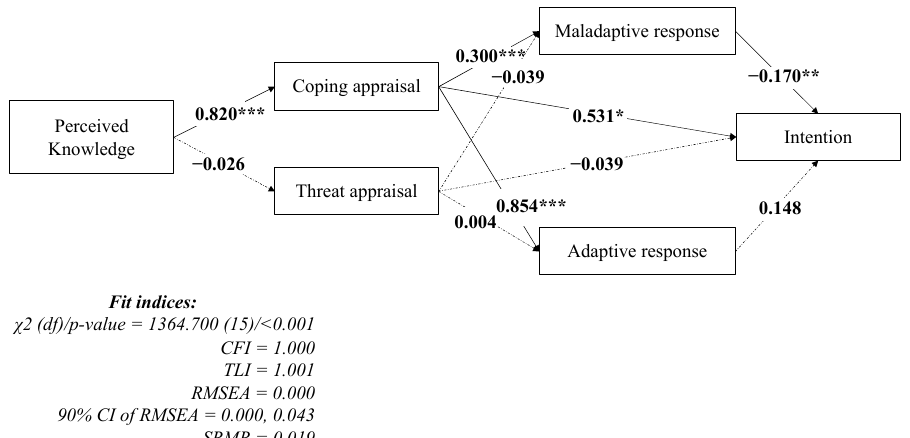
Figure 2. Confirmed model explaining the intention to get COVID-19 vaccination. Coefficients are presented using standardized coefficients. Solid lines indicate significant pathways while dashed lines indicate non-significant pathways. * p < 0.05; ** p < 0.01; *** p < 0.001. CFI = Comparative fit index; TLI = Tucker–Lewis index; RMSEA = root mean square error of approximation; SRMR = standardized root mean square residual.